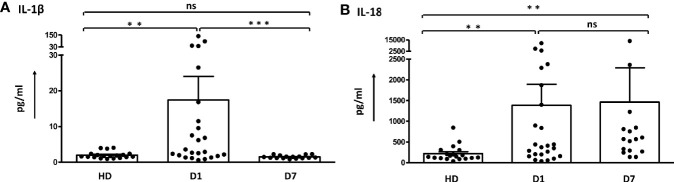
Dynamic change of serum levels of IL-1β and IL-18 in sepsis patients. (A) The concentration of IL-1β in sepsis patients was higher than in healthy donors on day 1 and decreased on day 7. (B) Values for IL-18 detected in sepsis patients remained increased. The difference was determined by Mann-Whitney test. **p < 0.01, ***p< 0.001. ns, not significant. Healthy donors n = 19; Sepsis patients day1 n = 24, day 7 n = 16. Dot plots and bar graph data are represented as mean ± SEM.